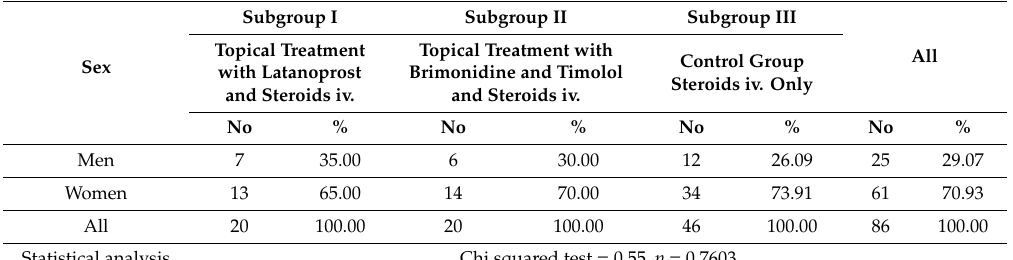
Table 1. Analysis of sex of the study population divided into three